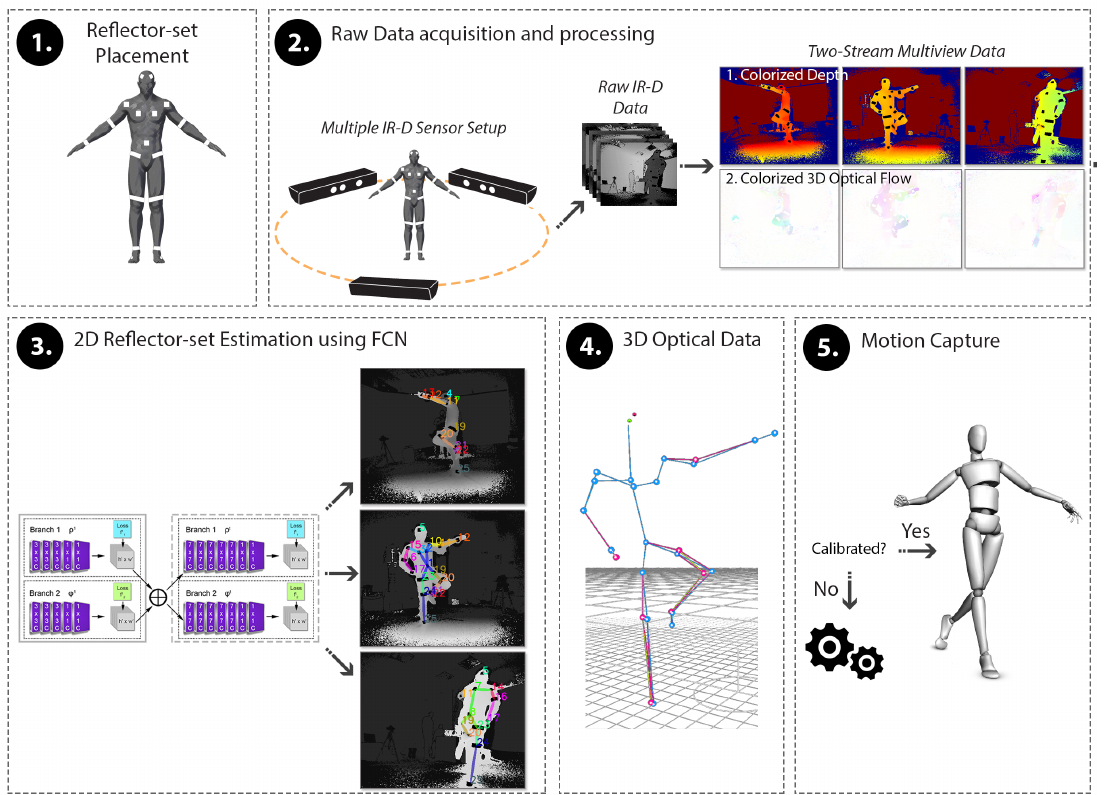
Figure 1. DeepMoCap pipeline overview. After the placement of the reflectors on the subject’s body (1), spatio-temporally aligned IR-D streams are acquired and processed (2) to feed the FCN with colorized depth and 3D optical flow images (3). The FCN outcome, i.e., the multi-view 2D reflector-set estimates, is fused to extract the 3D optical data (4) and, finally, yield the subject’s 3D pose for motion capture (5).